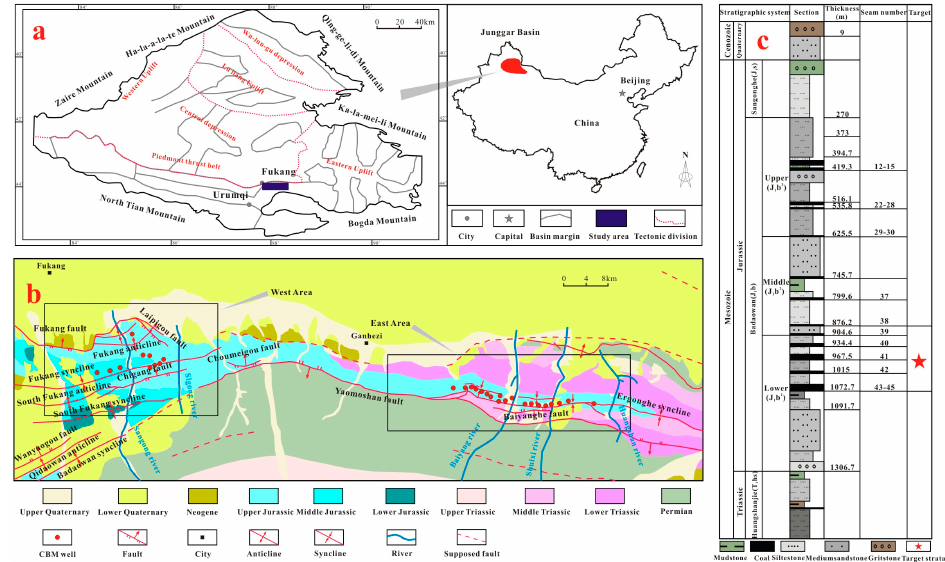
Figure 1. ( a ) Location and geological structure of study area in the SJB; ( b ) the distribution map of structural traps and fault systems of the SJB refer to Figure 1a for the study area locations; ( c ) a map showing stratigraphic section of the SJB, the combinations of the target strata in the Badaowan Formation strata are